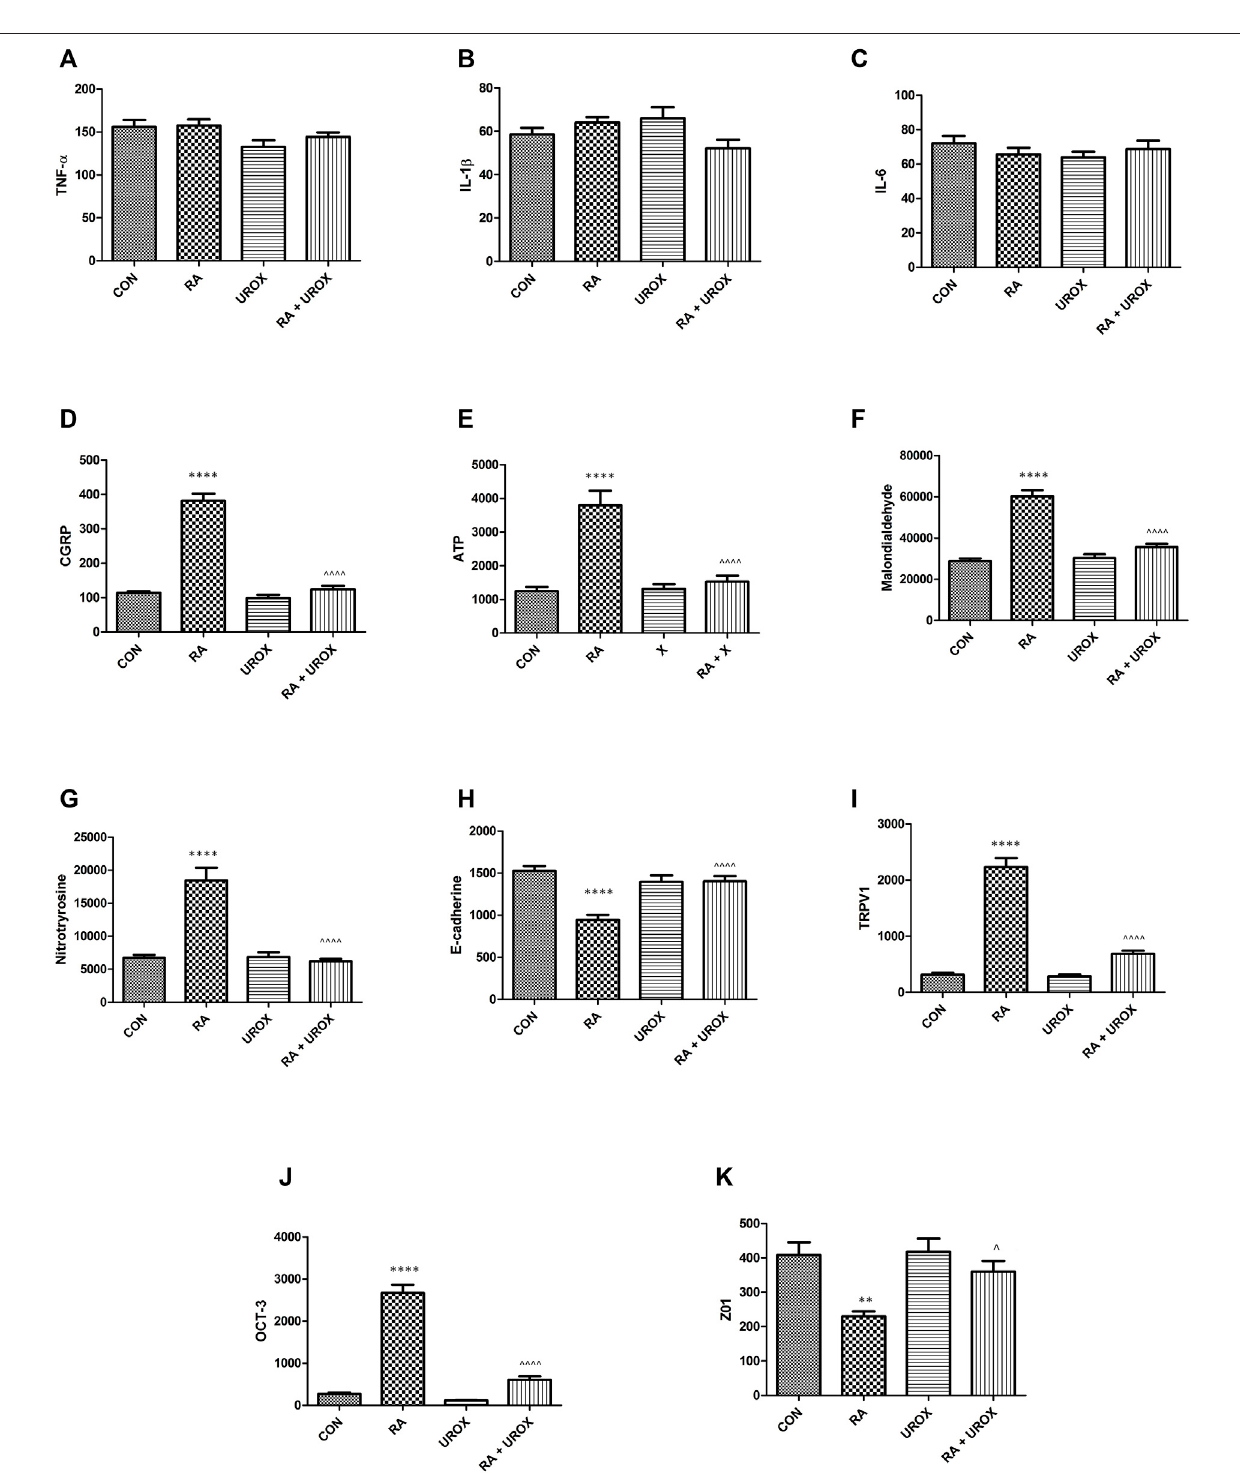
FIGURE 2| The in fl uence of the 14-day administration ofUrox ® (840 mg p.o.) on biomarkers ’ level (pg/ml) in the bladder urothelium: (A) TNF- α , (B) IL-1 β , (C) IL-6, (D) CGRP, (E) ATP, (F) malondialdehyde, (G) 3-nitrotyrosine, (H) E-cadherin, (I) TRPV1, (J) OCT-3, and (K) Z01 in rats subjected to a single injection of retinyl acetate (RA).Valuesareexpressedasmean±SEM.** p < 0.01,**** p < 0.001 versus saline, ^ p < 0.05, ^^^^ p < 0.0001 versus RA( n =15ratspergroup). One-wayANOVA:forCGRP: F(3.56) = 115, p < 0.0001; for ATP: F(3.56) = 24, p < 0.0001; for malondialdehyde: F(3.56) = 51, p < 0.0001; for 3-nitrotyrosine: F(3.56) = 31, p < 0.0001; for E-cadherin:F(3.56)= 16, p < 0.0001;for TRPV1: F(3.56) =113, p < 0.0001; forOCT-3: F(3.56) =122, p < 0.0001; and for Z01: F(3.56) = 7.5, p < 0.0001. CON,control.